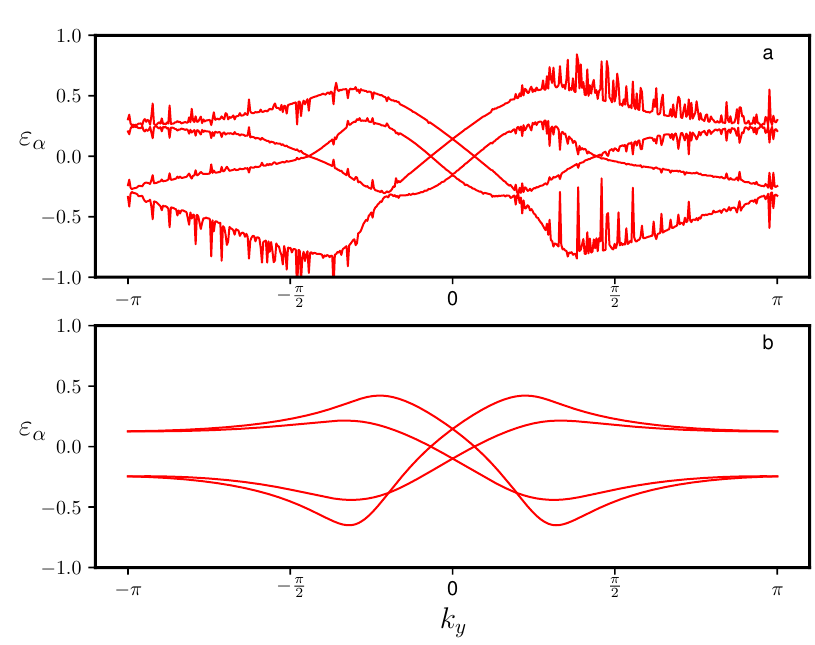
( E , k ) for the quantum spin Hall model (Sec. 5.2) as a function Figure 13: Eigenvalues of H eff of the momentum, E = − 0.4. In (a) the vectors Φ are normed but not orthogonalized, in (b) e the vectors are orthogonalized using a QR